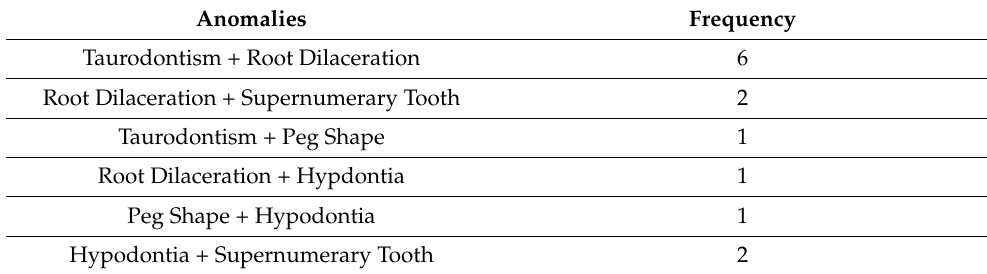
Table 3. Frequency of different anomaly